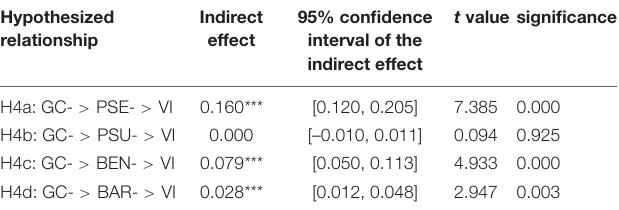
TABLE 6 | Significance analysis of the mediation